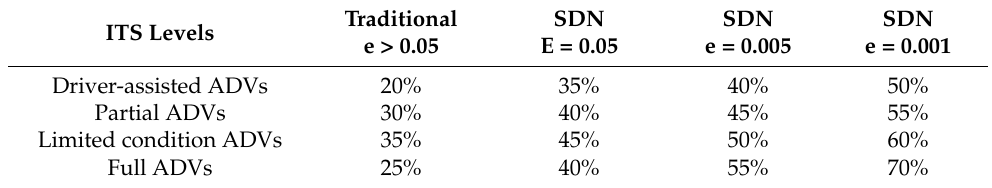
Table 3 is completed for managing the data traffic related to the transport